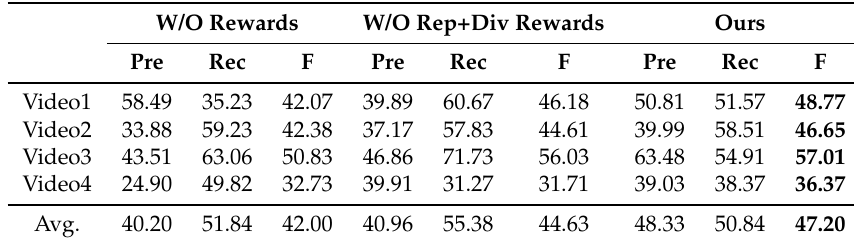
rewards, and one that does not make use of the representativeness+diversity rewards, but that are otherwise identical. Note that we repeat the results of the combined full model in this table, in order to provide a more convenient comparison. The best results (F-measure) are highlighted in